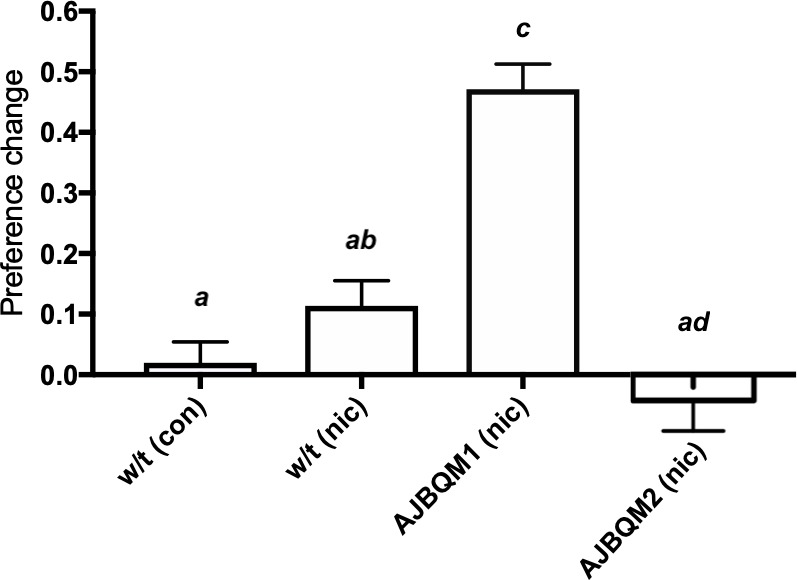
AJBQM1 and AJBQM2 families show increased and decreased nicotine place preference.AJBQM1 and AJBQM2 siblings, not included in the screen (n = 10 for AJBQM1; n = 14 for AJBQM2), AJBQM1 significantly differed from the parental strain, Tupfel longfin (TLF) wild type (w/t) saline control (n = 17) and wild type nicotine exposed fish (n = 7). AJBQM2 differed from wild type nicotine exposed fish but not wild type saline controls. Different superscript letters indicate significant difference between groups (p<0.05), same superscript letters indicate no significant differences between groups. Bars indicate Mean + SEM.Figure 3—source data 1.Confirmation of nicotine CPP phenotypes for Figure 3 and Figure 4.